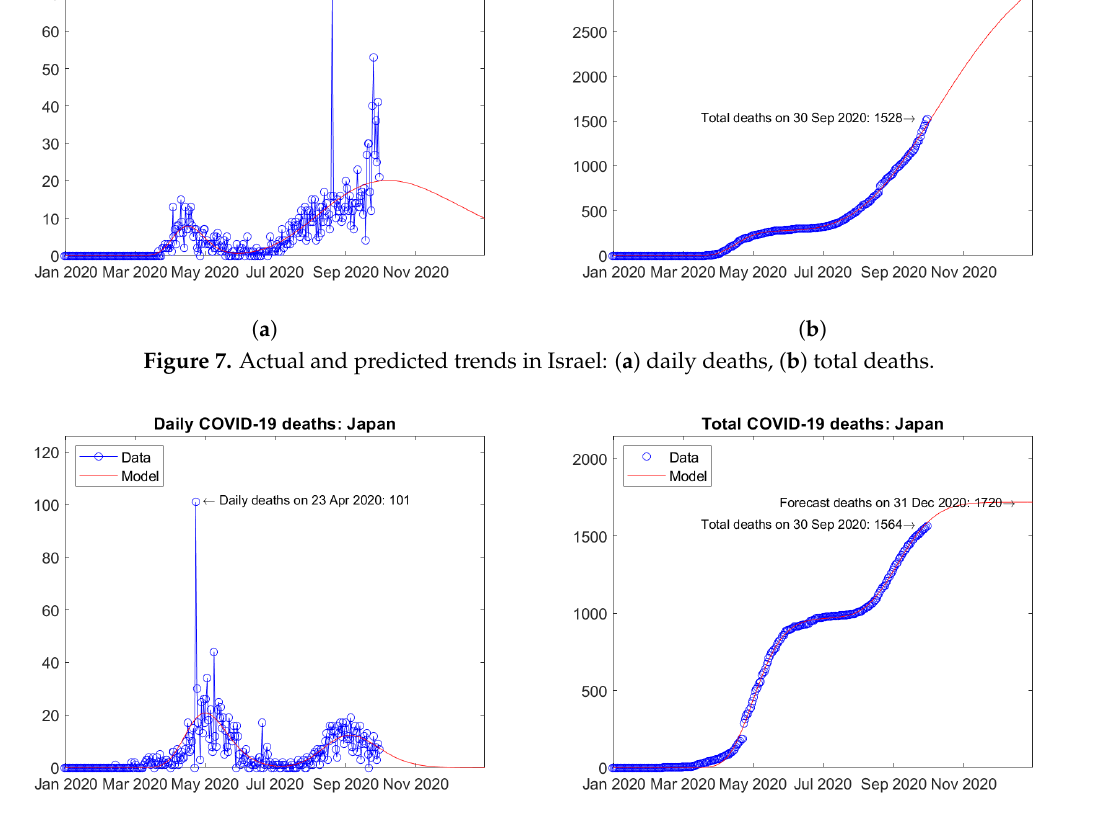
Figure 8. Actual and predicted trends in Japan: ( a ) daily deaths, ( b ) total